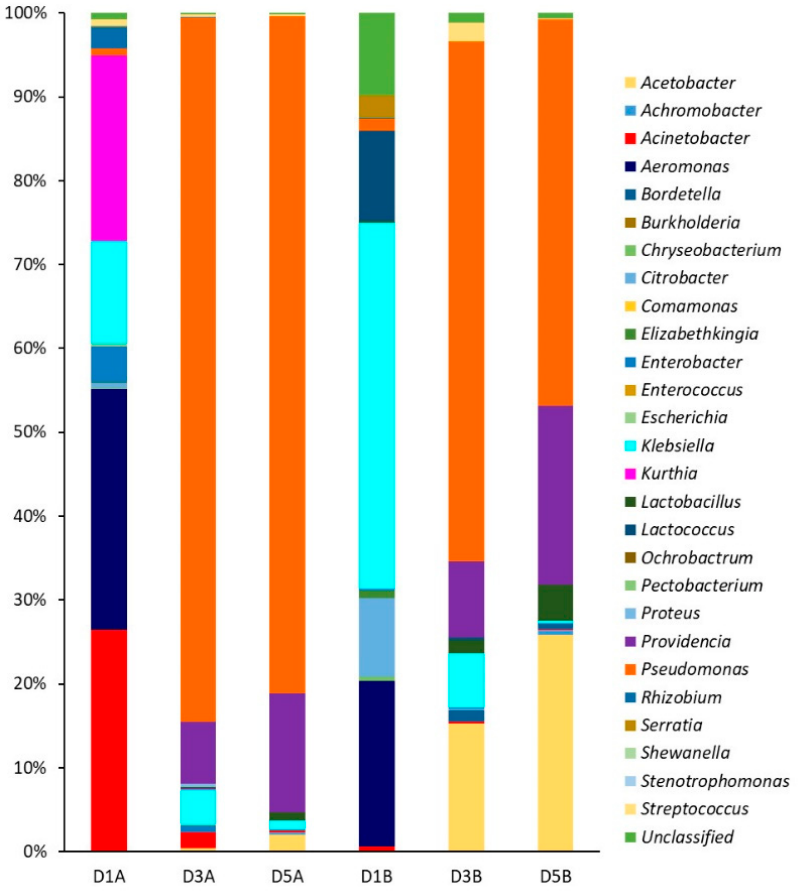
Figure 7. Relative abundance of species on DGGE gel at different biofilm maturation time and type